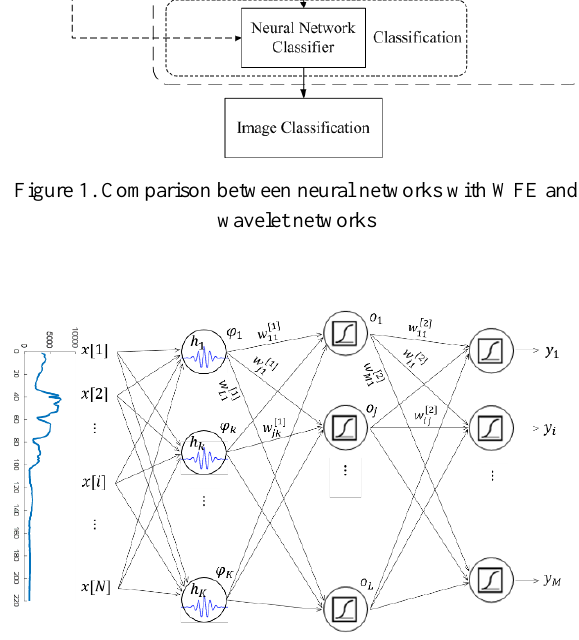
Figure 2. The structure of wavelet